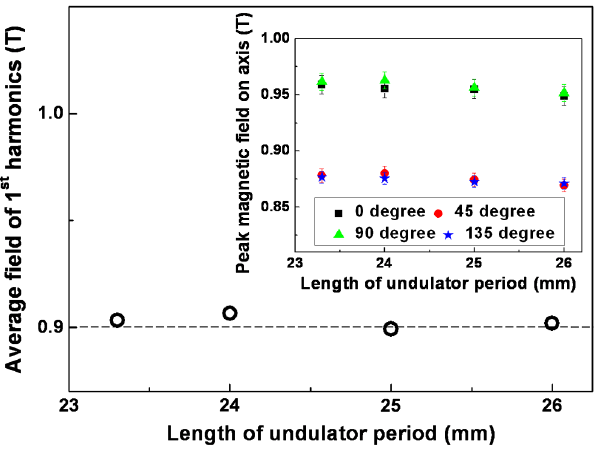
FIG. 8. Dependence of the average fundamental harmonics of magnetic field on the period length of the V-P helical undulator. The inset graph of the figure shows the peak magnetic field on the undulator axis.